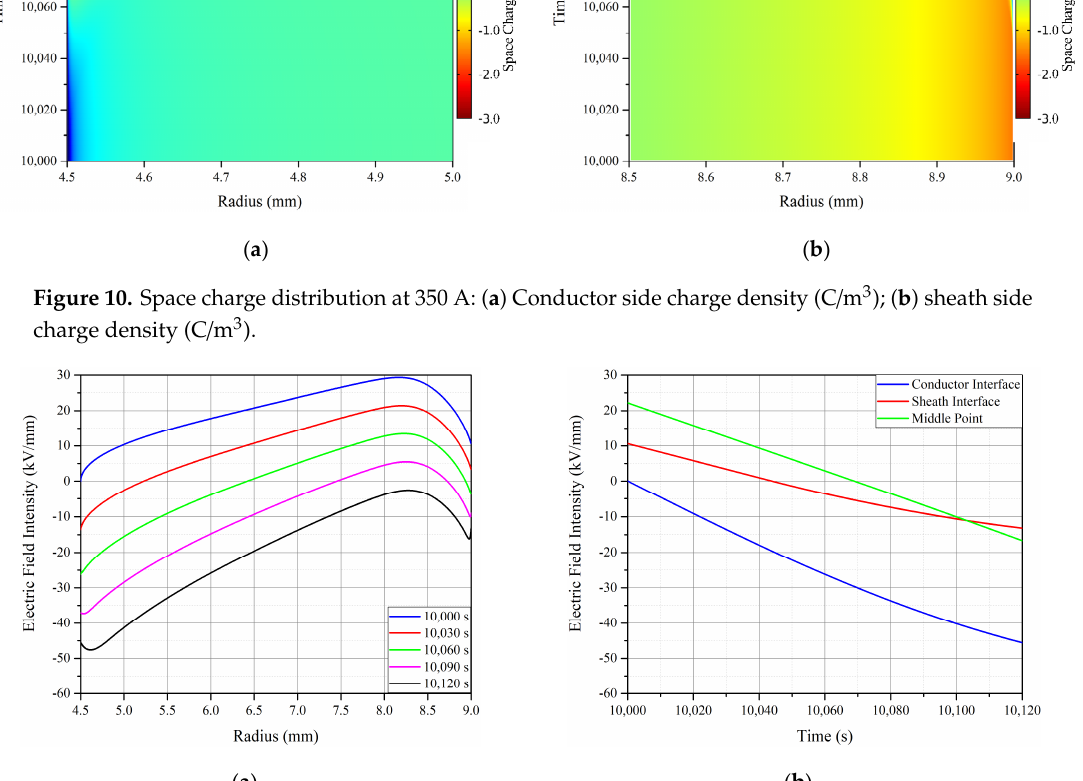
Figure 11. Time-varying electric field distribution at 350 A: ( a ) Within LDPE; ( b ) at each point.